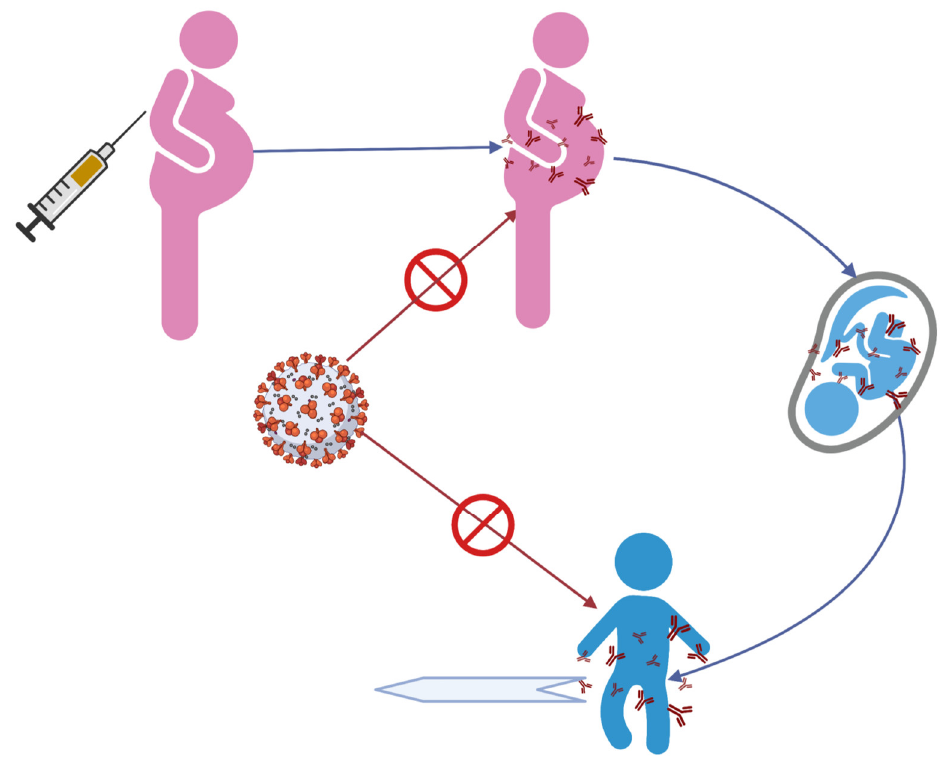
Figure 1. Proposed hypothesis for reducing the risk of MIS-C in infants after material COVID-19 vaccination. (Created with BioRender.com) access date 25th May 2022